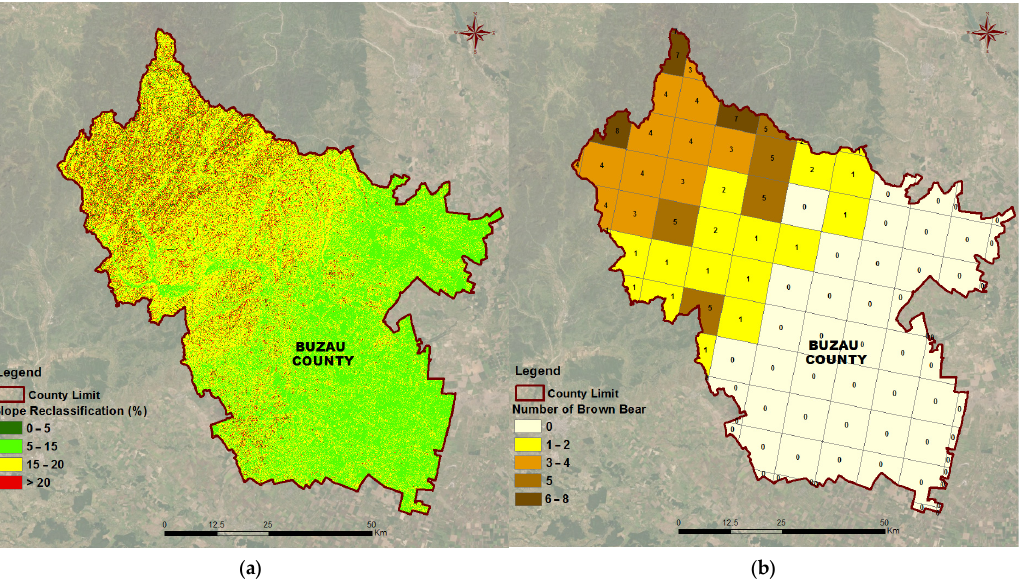
Figure 8. Results for the input data Terrain Slope ( a ). Following rasterization and standardization of this dataset, it is observed there are few steep slopes in the mountainous area of the county (the Buz ă u Mountains), which makes the brown bear move more easily in its habitat (map created by the authors); ( b ) Brown bear habitat in Buz ă u County. The map shows that the bear occurrence is higher in the northern part of the county (map processed after [34]).